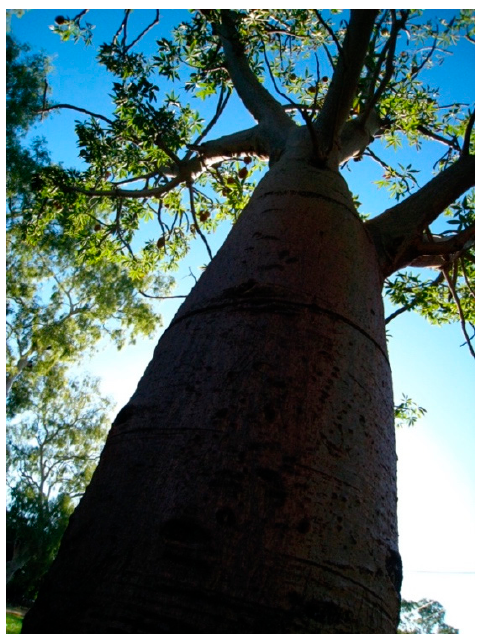
Figure 7. A boab tree ( Adansonia gregorri ) in Derby, Western Australia. Closely related to the African boabab, they are found in the Kimberly region of Western Australia and small parts of the Northern Territory. The pith of the tree is high in Vitamin C, the seeds can be roasted, and water is stored in its trunk, which was important for families during the dry season. According to Nykina elder Annie Milgin, boabs are home to spirits that come up from the roots and see out from the flowers (Cross 2019). Photograph by Rachel Breunlin.